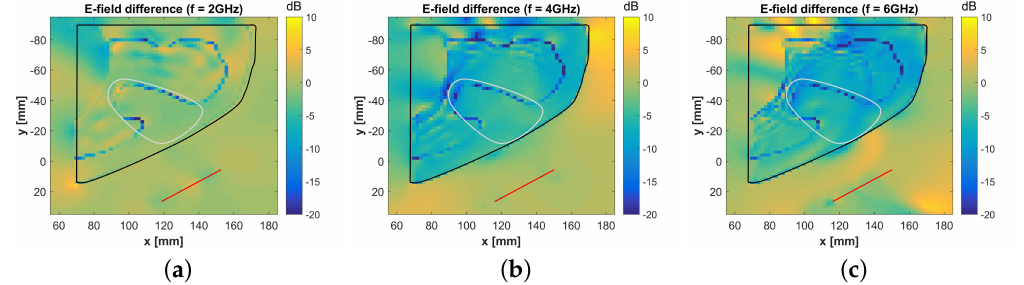
Figure 12. Effect of the developed phantom on the energy coupling inside the axillary region tissues. The plot represents the difference between the total field computed in Axilla model ( E axilla ) and the total field computed in the Phantom model ( E phantom ). The electromagnetic source is the XETS antenna illustrated in Figure 9a. The black line identifies the contour of the axillary region (i.e., skin or phantom surface in cross-sectional view). The white line identifies the axillary lymph node region. The red line identifies the antenna. ( a ) Frequency f = 2 GHz; ( b ) f = 4 GHz; ( c ) f = 6